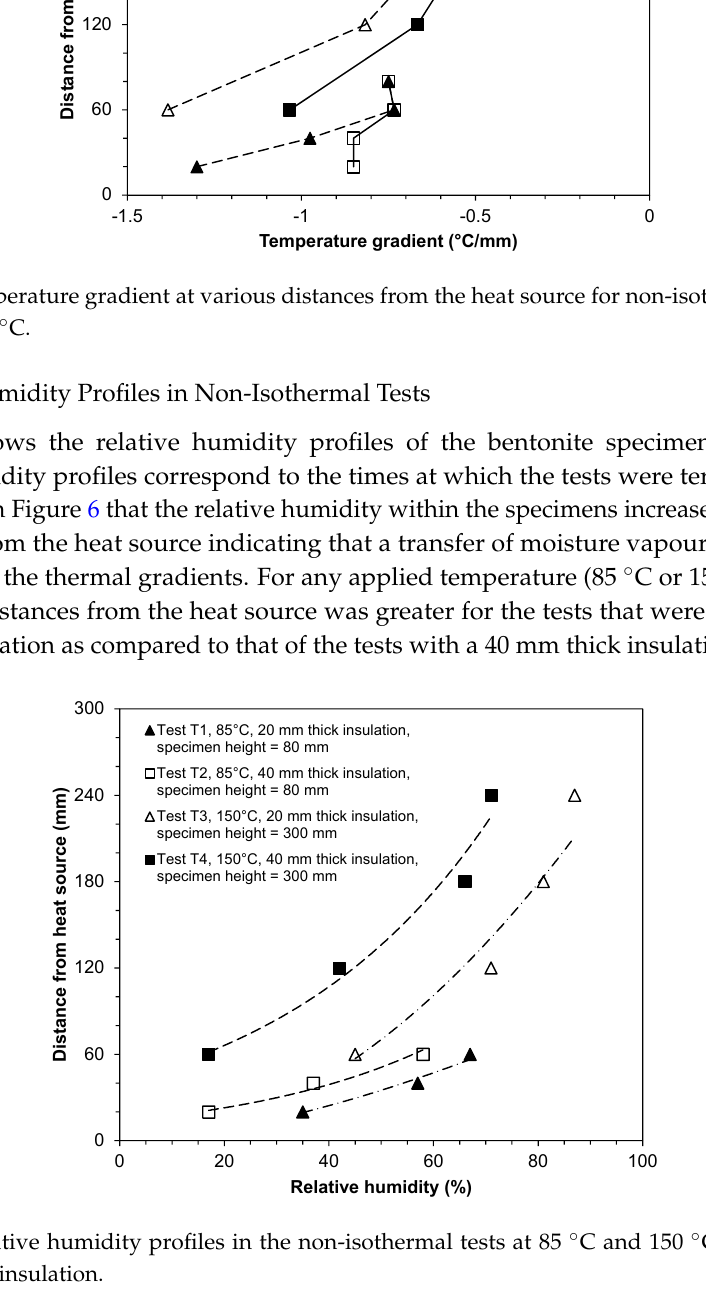
Figure 6. Relative humidity profiles in the non-isothermal tests at 85 °C and 150 °C with various thicknesses of insulation.